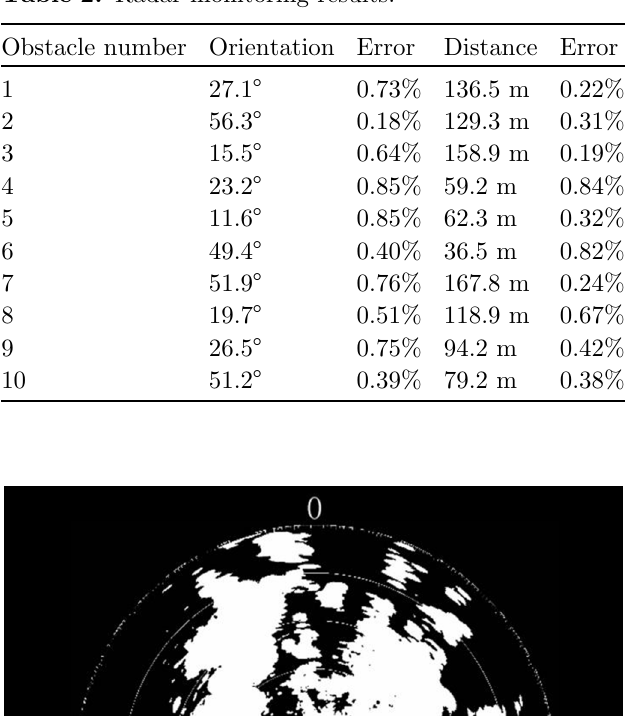
Table 2. Radar monitoring results.